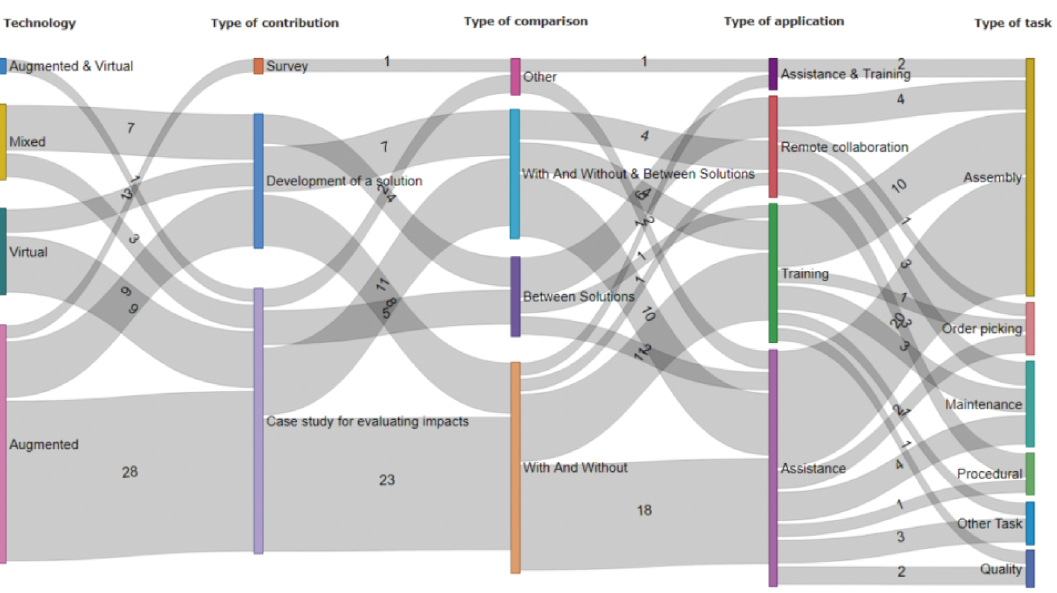
Figure 5. Sankey diagram of papers’ analyzed